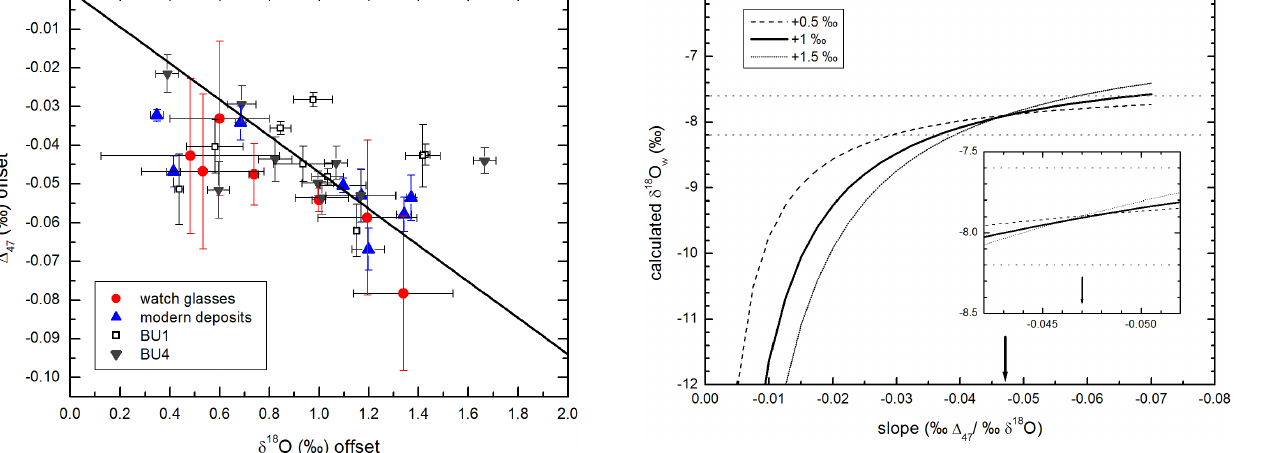
Fig. 2. 1 47 versus δ 18 O offsets for Holocene stalagmites BU1 and BU4 as well as modern speleothems (adapted from Kluge and Af- fek, 2012). The offsets of the Holocene BU1 and BU4 samples were calculated for illustration purposes assuming a constant drip-water δ 18 O value of − 7.9‰ and a constant temperature of 9.5 ◦ C (8.5 ◦ C for BU4-9). The straight line is the slope obtained from a linear fit of modern calcite precipitates (Fig. 1). Deviations of BU1 and BU4 samples from this line are likely due to slight deviations of the actual climatic parameters from the assumption of a constant temperature and drip-water δ 18 O value (see Supplement Sect. A3).